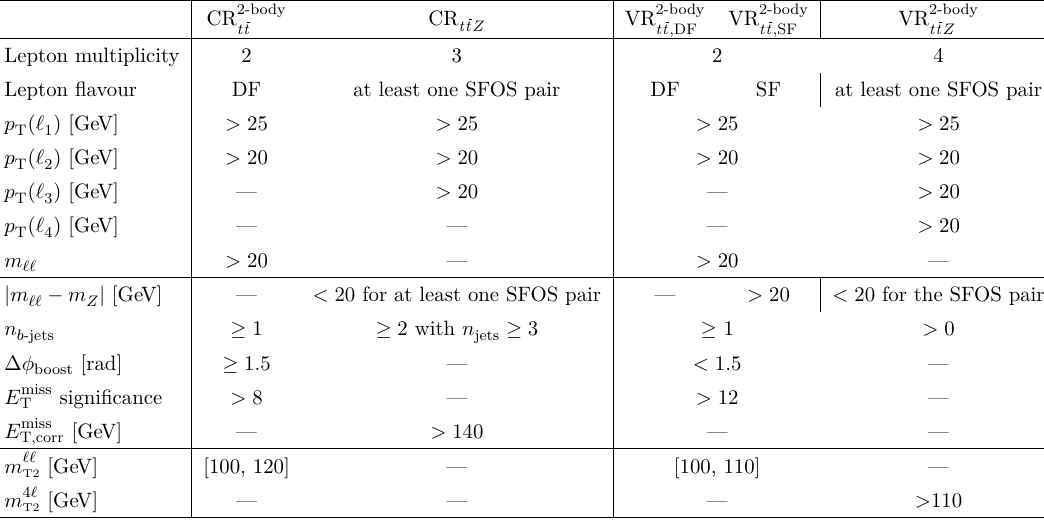
Table 6 . Two-body selection. Control and validation regions definition. The common selection defined in section 5 also applies to all regions.